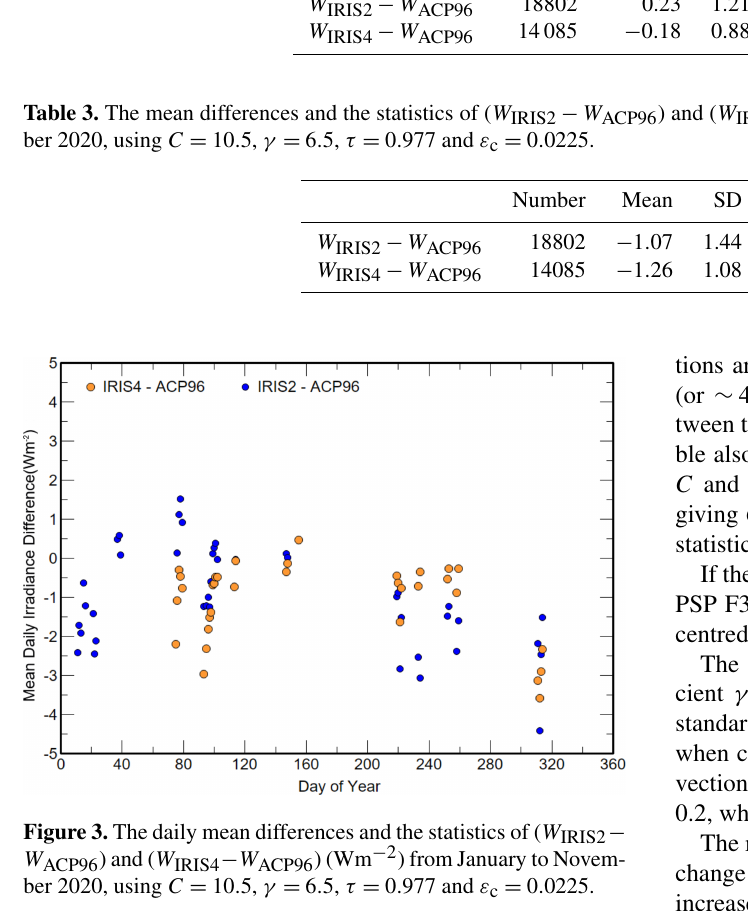
of the W IRIS2 − W ACP96 , while the W IRIS4 − W ACP96 showed little